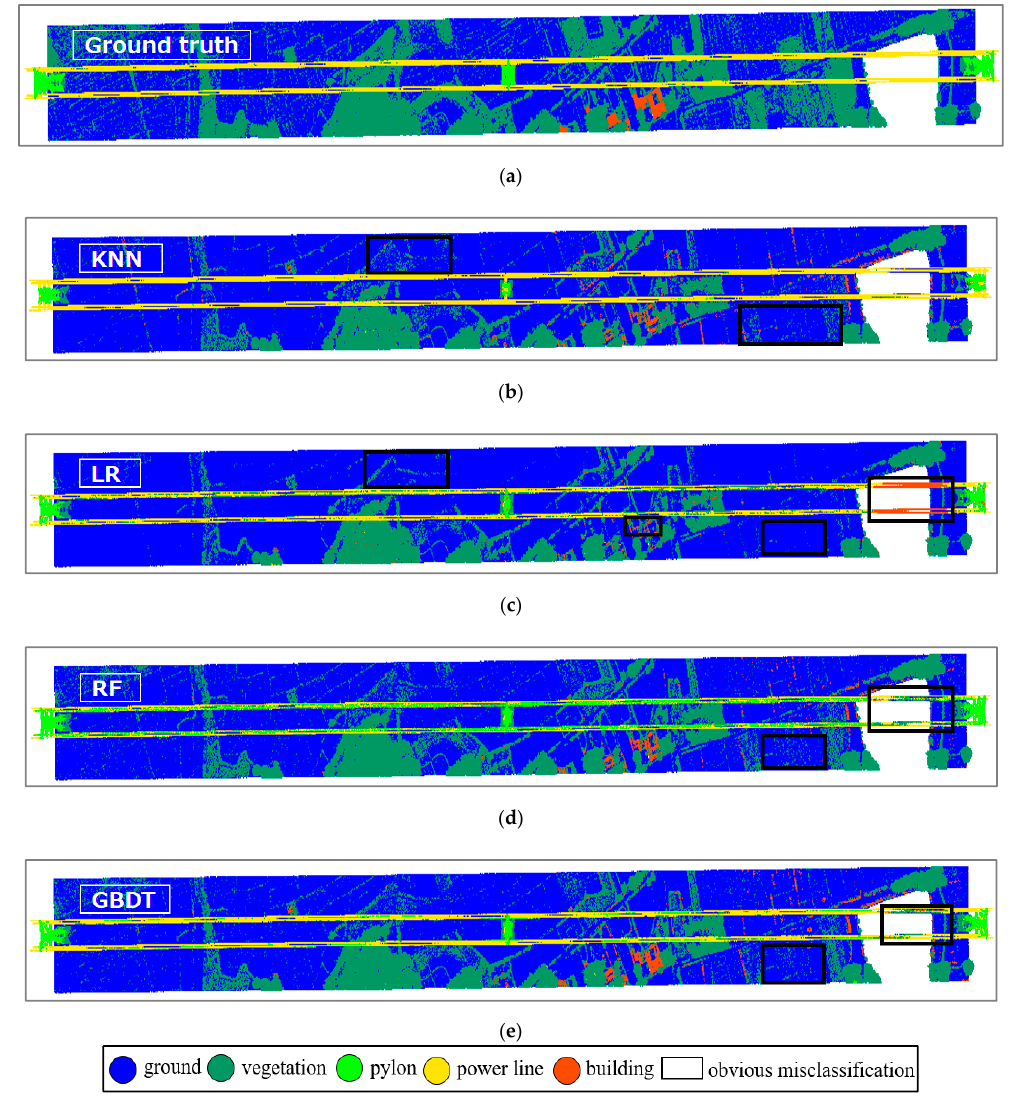
Figure 8. The classification results of site III with different classifiers: ( a ) The point clouds colored by the true labels; ( b ) the point clouds colored by the KNN prediction results; ( c ) the point clouds colored by the LR prediction results; ( d ) the point clouds colored by the RF prediction results; ( e ) the point clouds colored by the GBDT prediction results. The black box is an area of obvious